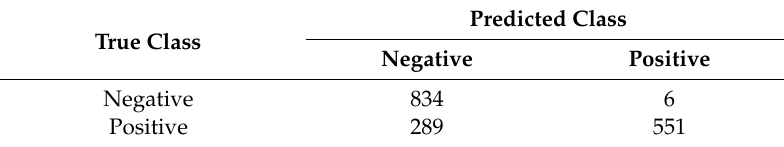
Table 8. Deep FC1 features and KNN classifier.